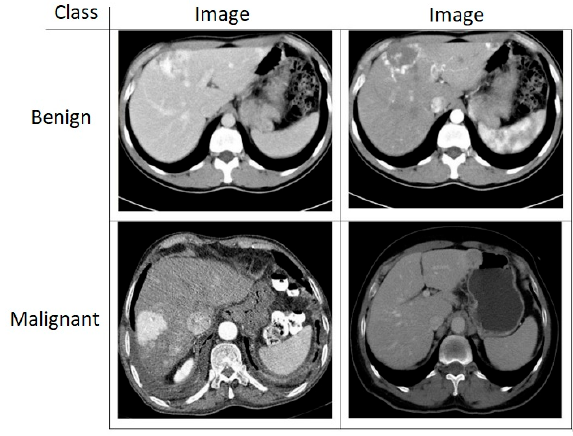
Figure 5. Computed tomography (CT) images of liver tumors.